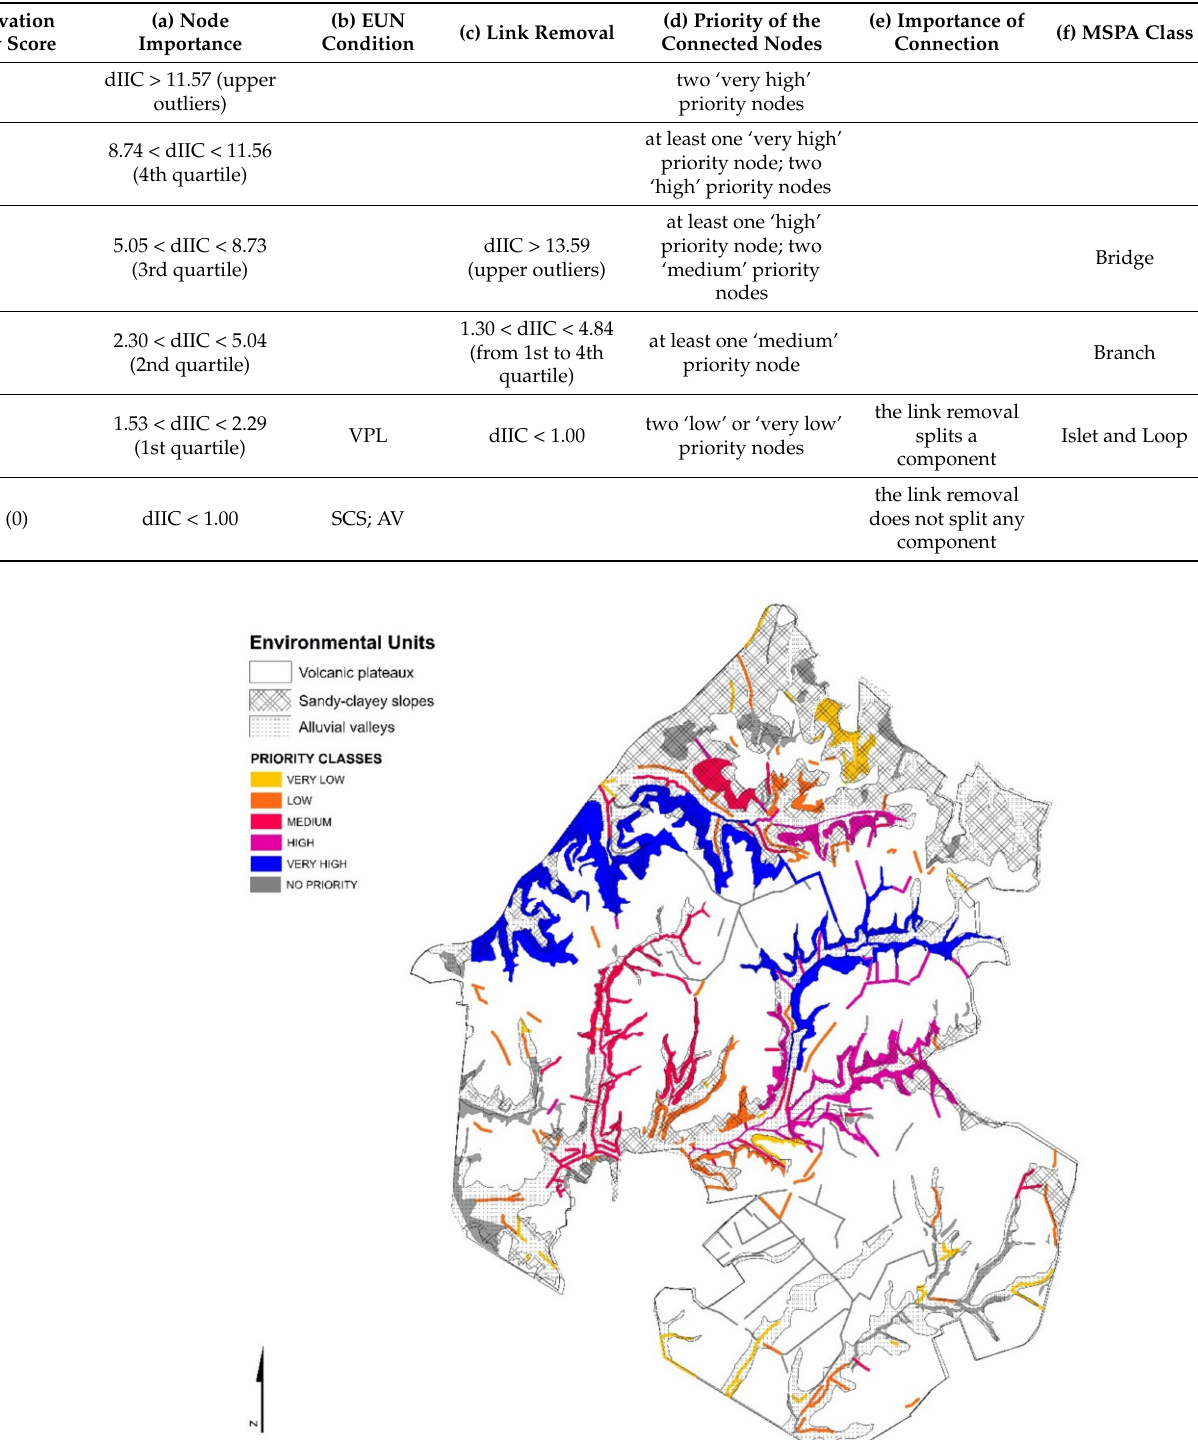
Table 3. Conservation priority scores assigned to GI components, at the level 4 stratified per EUN, according to individual indicators (a and b for areal components, and from b to f for linear components, respectively).